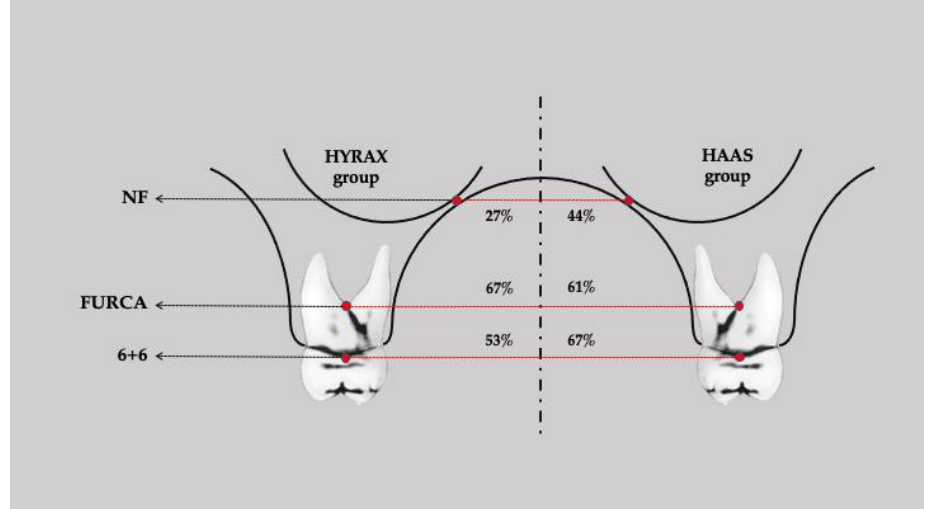
Figure 2. Representation of the percentage amount of expansion at different levels (NF, FURCA, and 6 + 6) compared to the total amount of dental expansion on the anchorage unit (E + E) between Hyrax and Haas group after RPE.